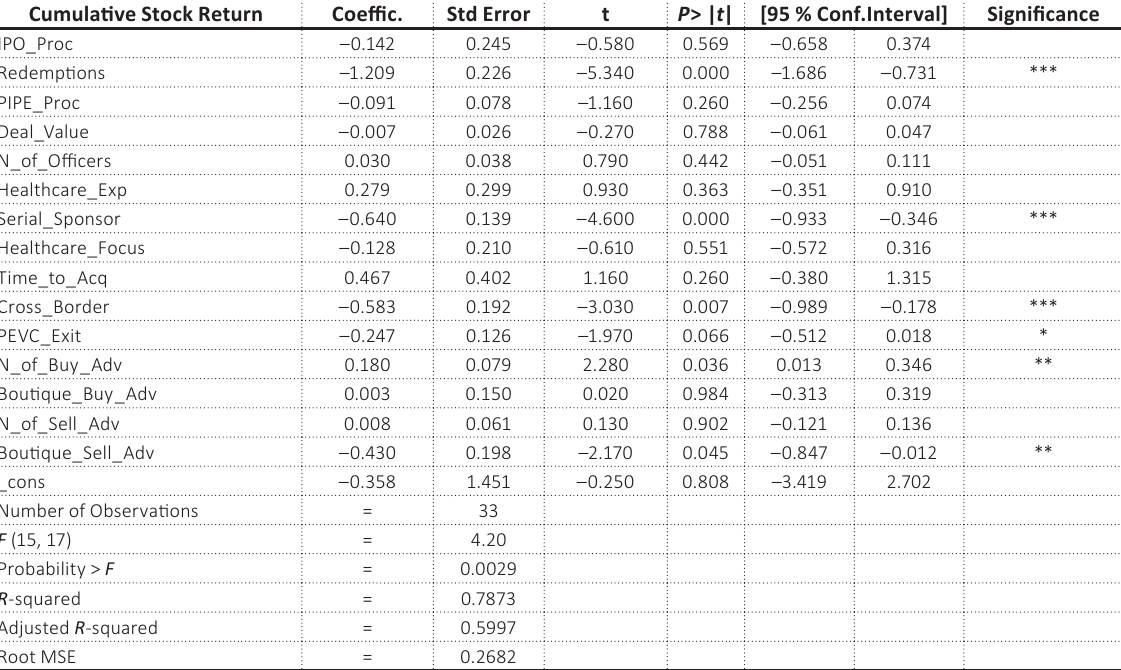
Table 4. Multiple linear regression